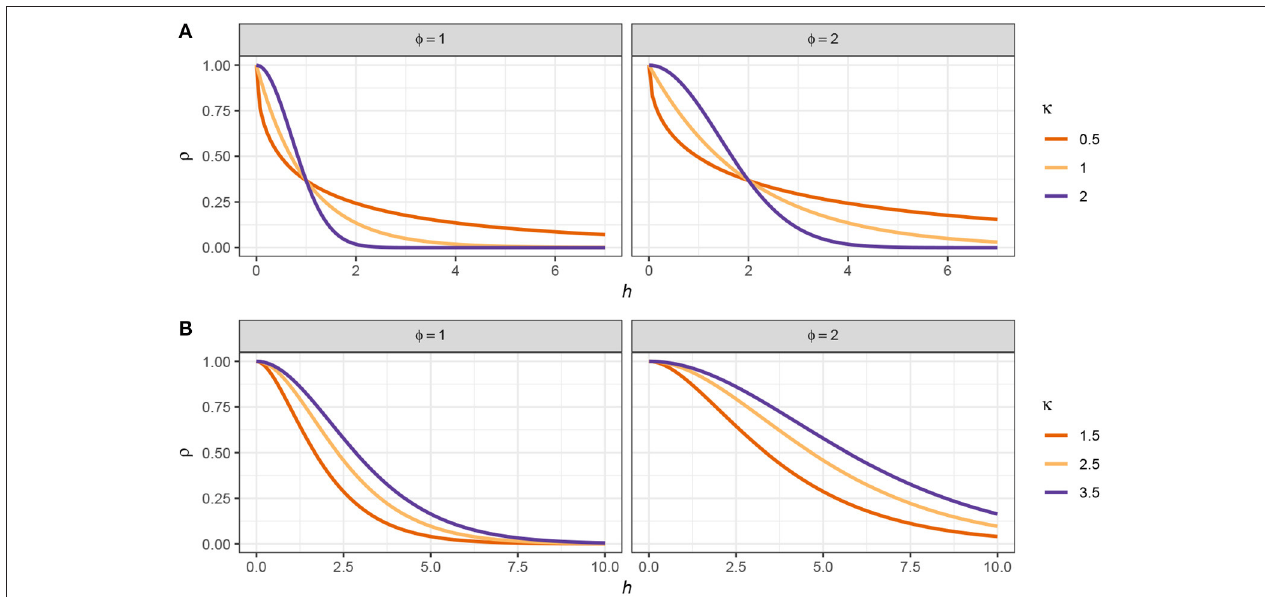
FIGURE 12 | Power exponential (A) and Matérn (B) correlation functions for observation separation distance h . Two values of the effective range parameter ( φ ) are shown for each function. For the power exponential function, κ is the power in the power exponential function. For the Matérn correlation function, κ distinguishes the member of the Matérn family.